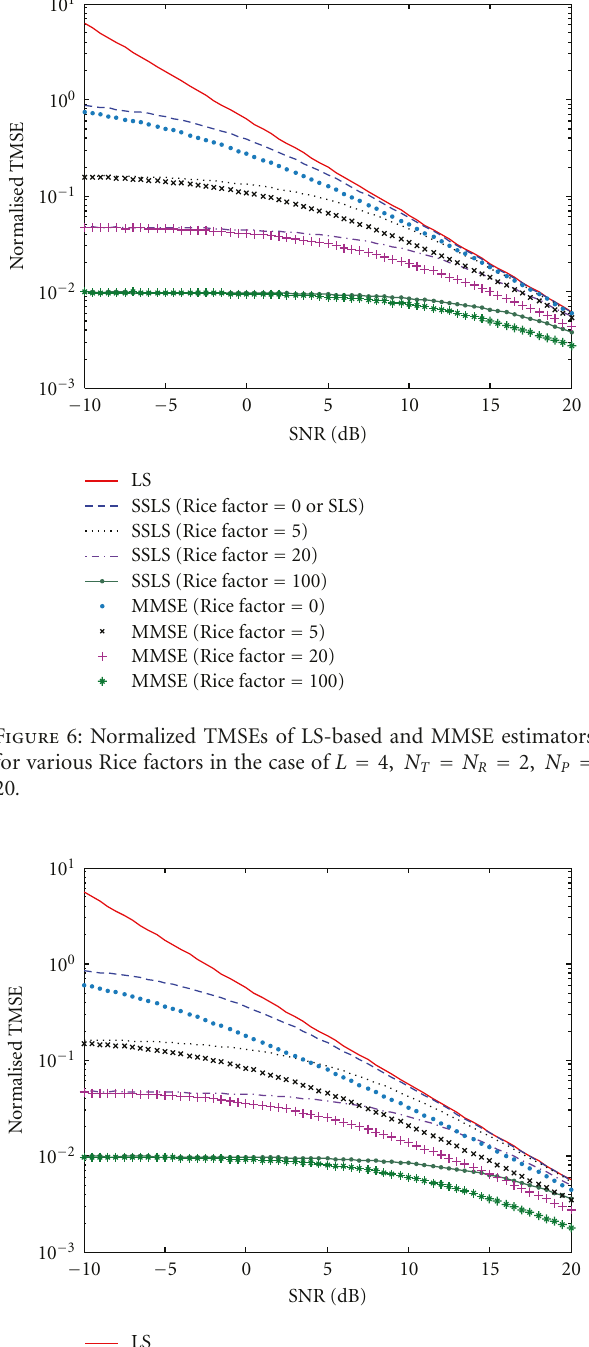
Figure 9: Normalized TMSEs of the MMSE estimator versus SNR in Rayleigh and Rician fading MIMO systems with L = 8, N P = 72